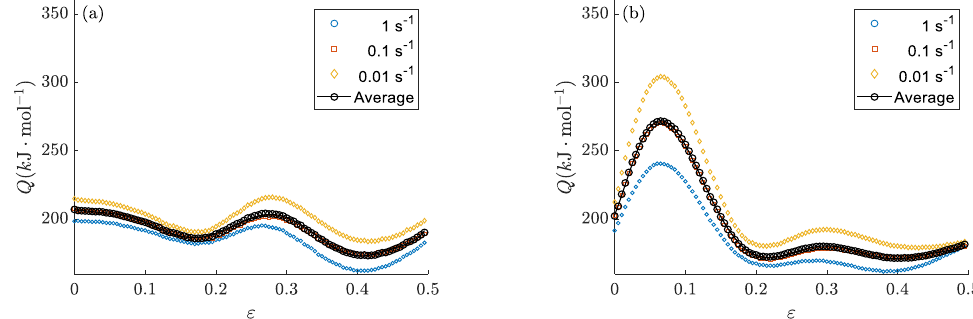
Figure 6. The estimated activation energies as functions of strain and strain rate, with α and n being ( a ) functions of strain, and ( b )